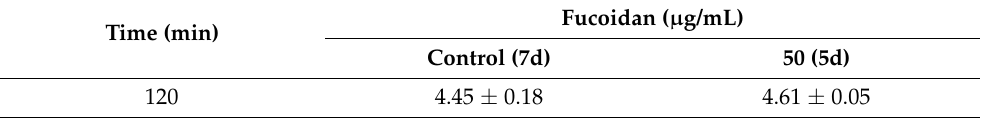
Table 3. Differences in the apparent permeability coefficient (Papp) of FITC-transferrin absorption ( × 10 − 5